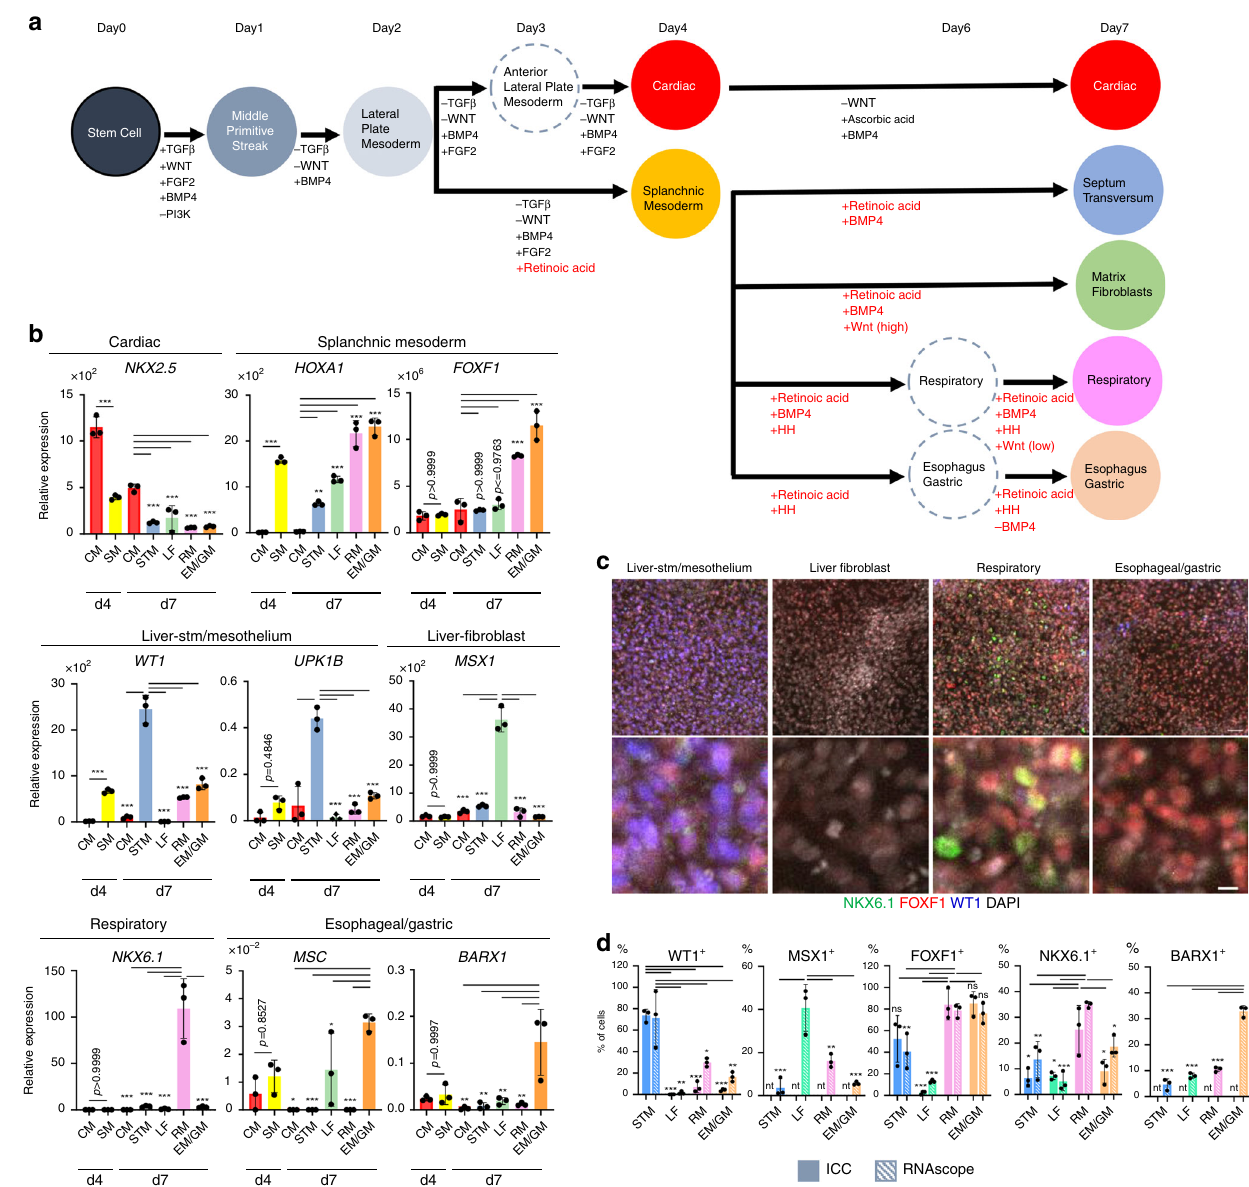
Fig. 7 Generation of splanchnic mesoderm-like progenitors from human PSCs. a Schematic of the protocol to differentiate hPSCs into SM subtypes. Factors in red indicate signals predicted from the mouse single-cell signaling roadmap. b RT-PCR of markers with enriched expression in speci fi c SM subtypes based on the mouse single-cell data: cardiac ( NKX2-5 ), early SM ( FOXF1, HOXA1 ); liver stm/mesothelium ( WT1, UKP1B ), liver- fi broblast ( MSX1 ), respiratory SM ( NKX6-1 + , MSC − ), esophageal/gastric ( MSC, BARX1 ). The histogram shows the means ± S.D. Statistical signi fi cance was calculated using a two-sided Tukey ’ s multiple comparisons test. * p < 0.05, ** p < 0.005, *** p < 0.0005. Exact p -values were provided in Source data fi le. n = 3 independent biological samples. Similar results were obtained from fi ve independent experiments. c Representative images of Day 7 cell cultures immunostaining. Similar results were obtained from three independent experiments. Scale bar; 50 μ m (upper panels), 10 μ m (lower panels). d Quanti fi cation of % cells positive for the indicated immunostaining or RNA-scope in situ hybridization. Histograms show the means± S.D. n = 3 independent fi elds. Immunostaining quanti fi cation results were similar for two separate experiments and RNA-scope validation was performed once. Statistical signi fi cance was calculated using two-sided Dunnett ’ s multiple comparisons test. * p < 0.05, ** p < 0.005, *** p < 0.0005. Exact p -values were provided in Source data fi le. ns; not signi fi cant, nt; not tested. Source data are provided as a Source data fi